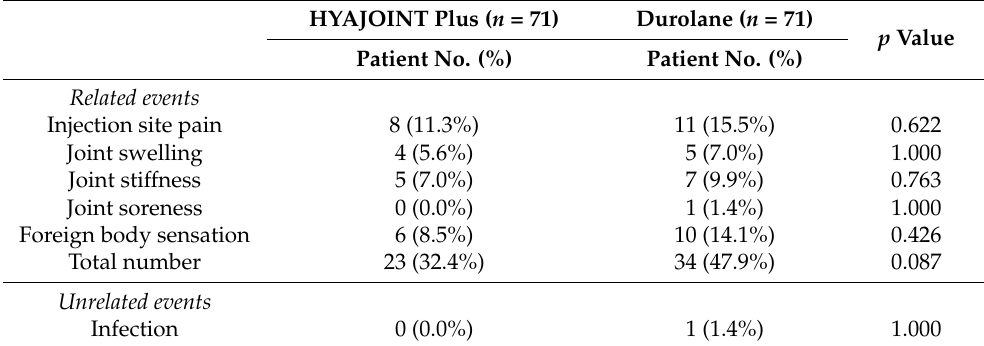
Table 5. Adverse events reported in the study